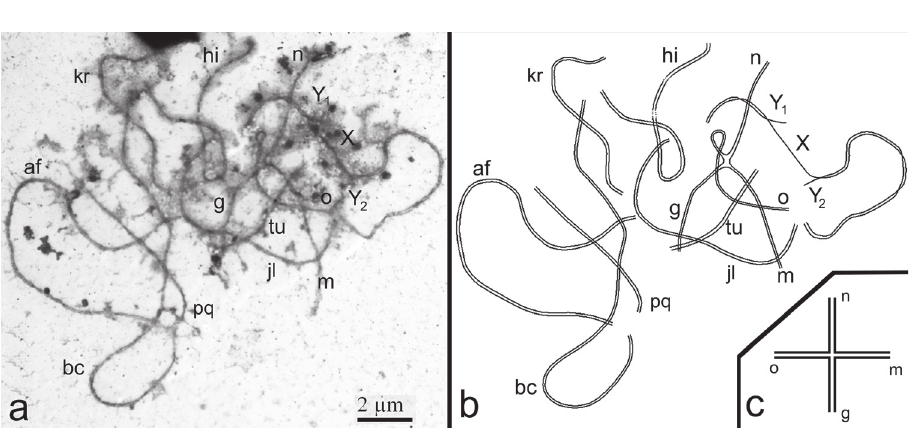
Y and the SC tetravalent ( g/o/n/m ) are 1 2